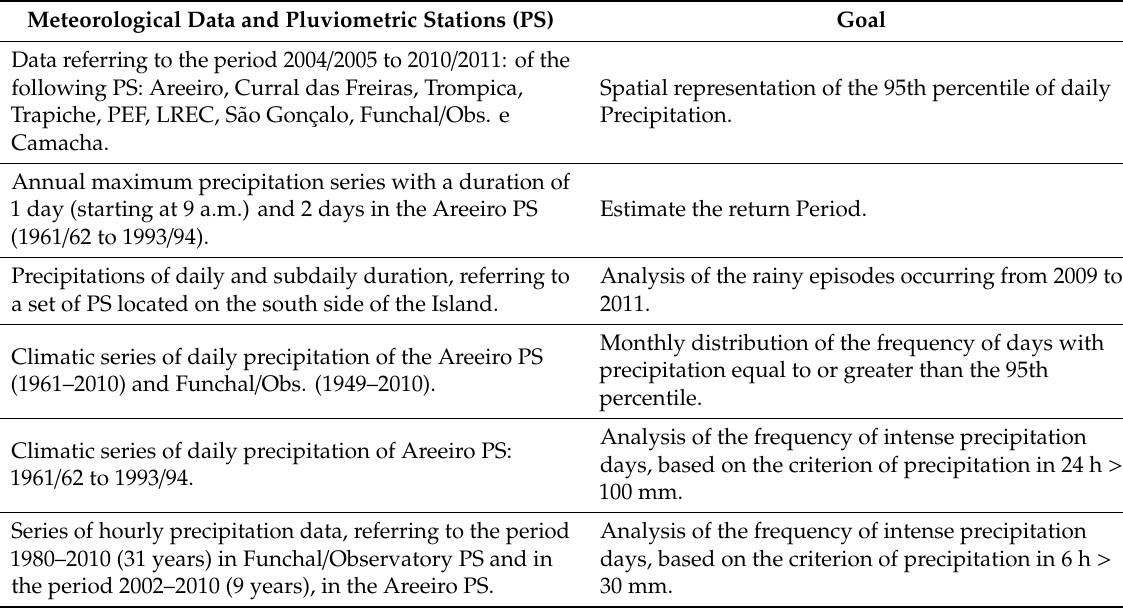
Table 2. Basic information on the precipitation data used in this